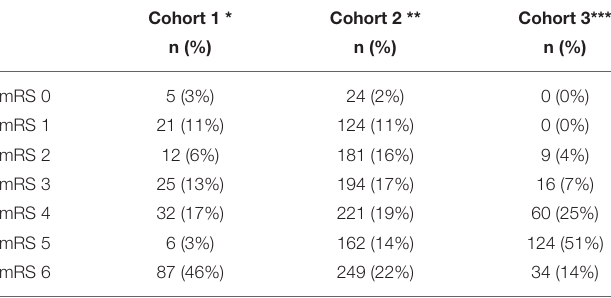
TABLE 1 | Initial distribution of